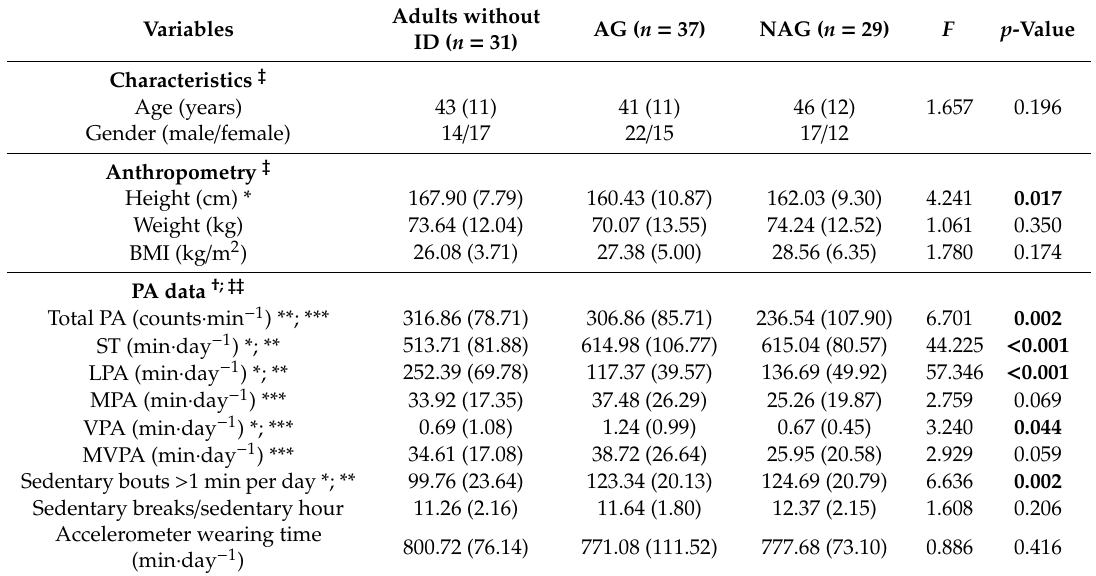
Table 2. Participants’ characteristics, anthropometry indices and PA